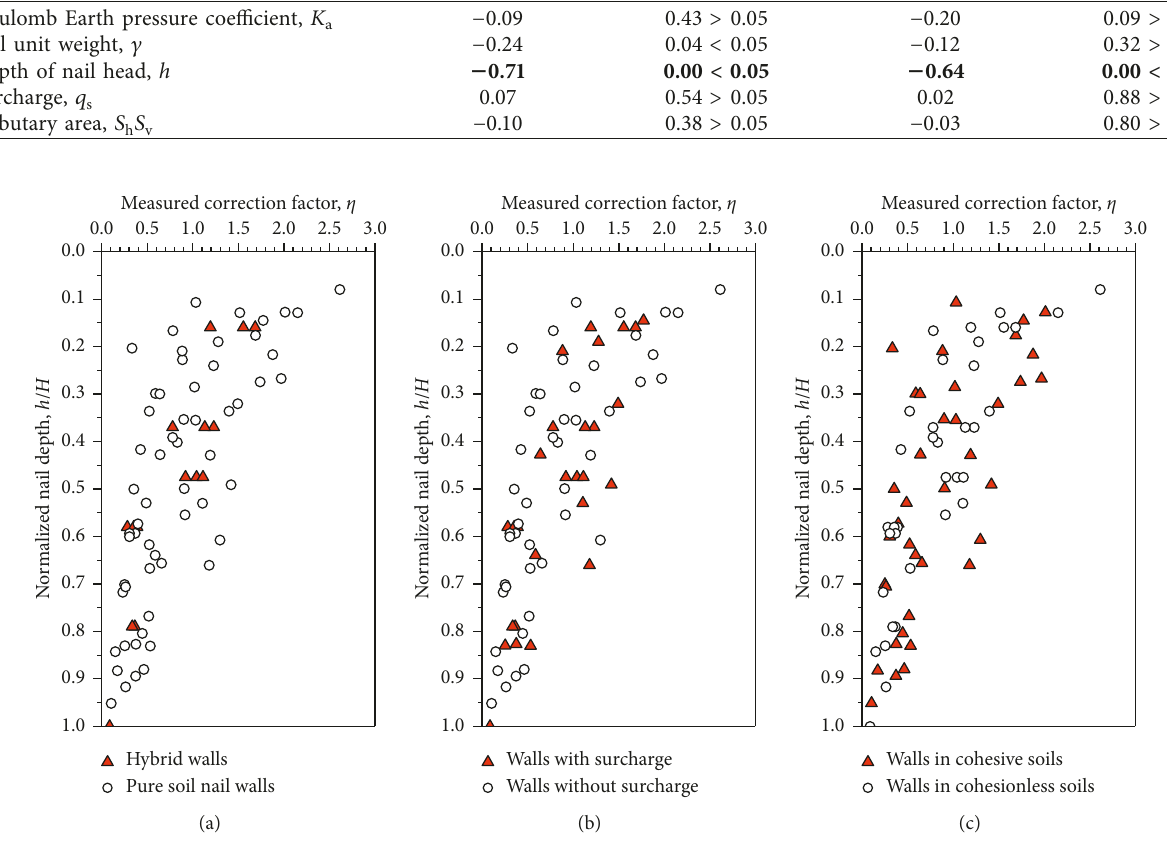
Table 3: Outcomes of correlation tests between measured η values and values of input parameters based on data group 1 ( n Input parameter